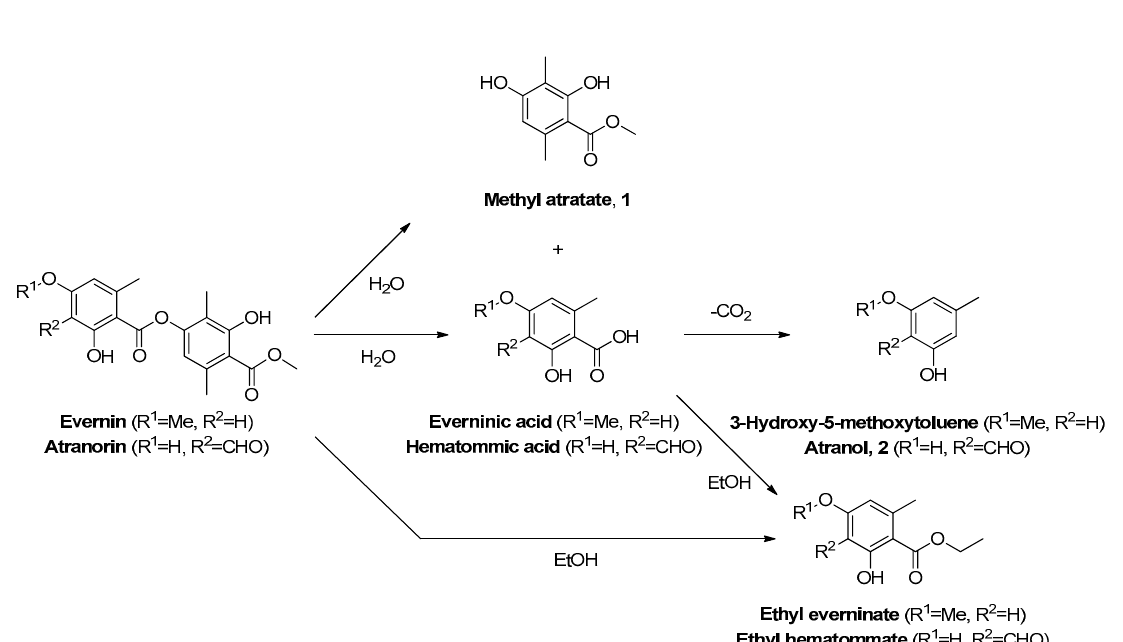
Figure 1. Evernin and atranorin solvolysis to monoaromatic compounds.